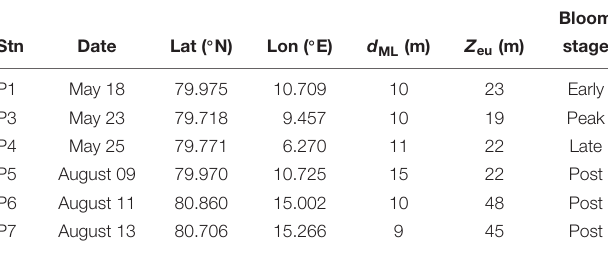
TABLE 1 | Location of 24 h process stations in May and August 2014.